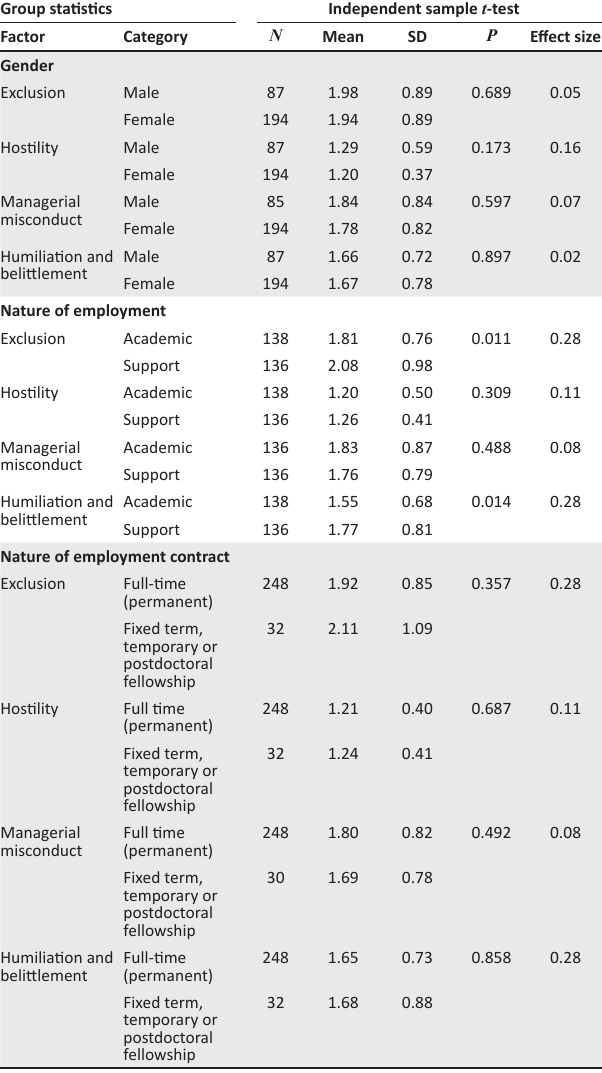
TABLE 3: Effect of gender, nature of employment and nature of employment contract on workplace bullying. Group statistics